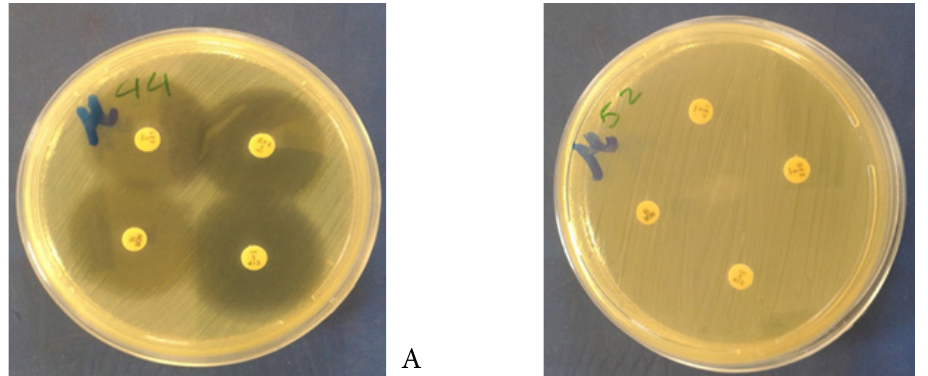
Fig. 6. Fluoroquinolones susceptibility of isolated E. coli to different fluoroquinolones using disk diffusion method (A): An E. coli isolate showing sensitivity to all used fuoroquinolones (B): An E. coli isolate showing resistance to all used